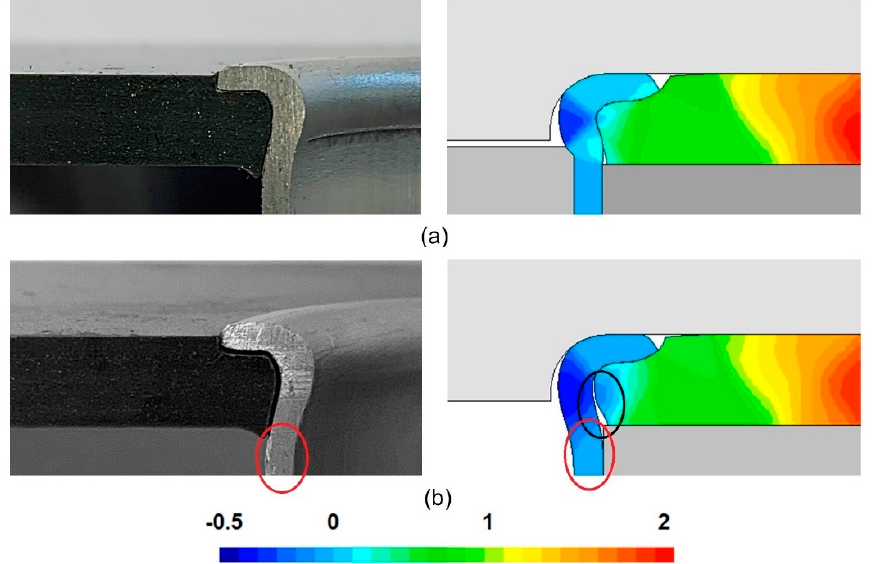
Figure 8. Experimental and finite element computed cross-sections of the joining by tube flaring and sheet squeezing of Aluminum AA 6063-T6 tubes to PVC sheets: ( a ) With an inner mandrel ( r c = 3 mm, h = 4 mm); and ( b ) Without an inner mandrel ( r c = 3 mm, h = 4 mm). The shaded finite element contour corresponds to the normalized radial velocity v r / v 0